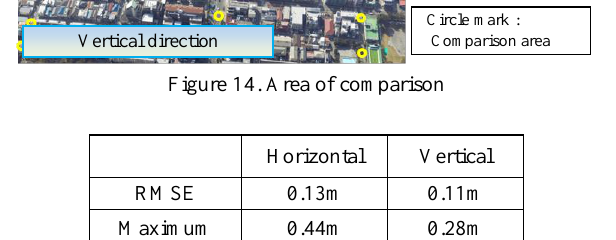
Table 4. Comparison of digital mapping, Nadir view image and